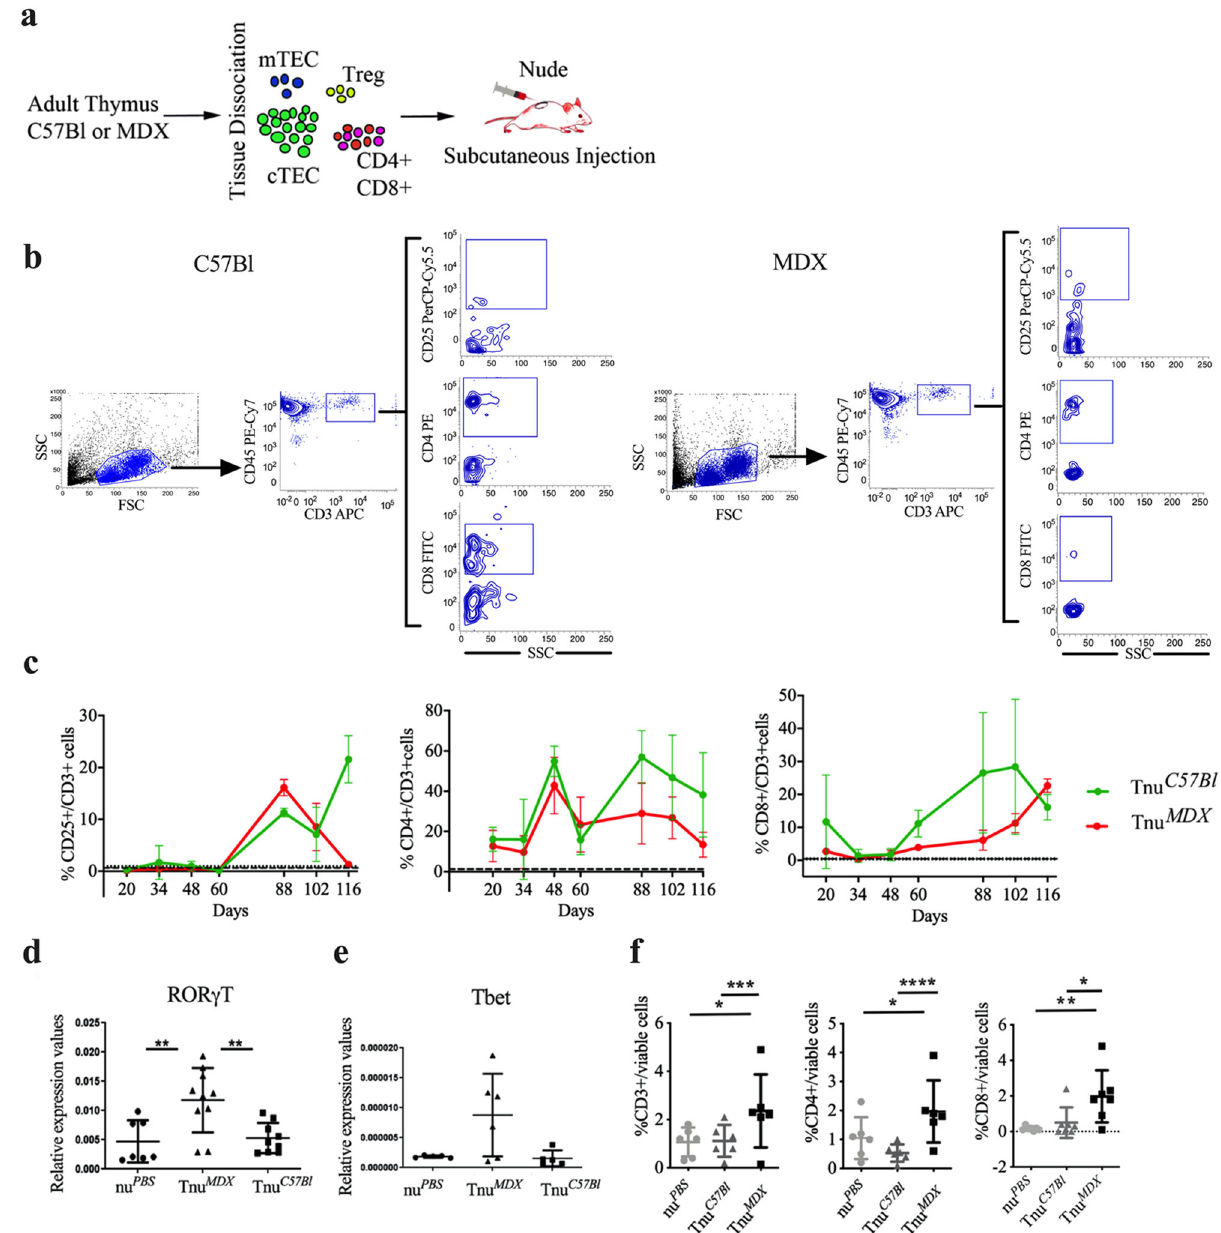
Fig. 5 Characterization of nude mice following adult thymus transplantation. Schematic overview of the experimental procedure ( a ). Gating strategy to identify CD25 + /CD3 + , CD4 + /CD3 + and CD8 + /CD3 + cell subpopulations in Tnu C57Bl and Tnu MDX mice. All subpopulations are detected within CD45 + CD3 + gate ( b ). FACS analysis of CD3-expressing blood-derived subpopulation isolated from Tnu C57Bl and Tnu MDX mice at different days following the thymus transplantation. Dashed lines referred to averaged values of nu PBS mice used as controls. The number of the CD3 + , CD4 + and CD8 + T cells were signi fi cantly higher in Tnu MDX muscles related to Tnu C57Bl and nu PBS mice ( c ). RT-qPCR analysis revealed signi fi cant over-expression of Th17 key gene, ROR γ t ( d ) and the upregulation of Th1 key gene T-bet ( e ) in muscles of Tnu MDX mice. f FACS analysis of muscles isolated from Tnu C57Bl , nu PBS mice and Tnu MDX mice for quanti fi cation of mature in fi ltrating T cells. The number of the CD3 + , CD4 + and CD8 + in fi ltrating T cells were signi fi cantly higher in Tnu MDX muscles related to Tnu C57Bl and nu PBS mice. The comparisons among the averages of the groups were evaluated using Linear regression analysis ( b ) and one-way ANOVA ( d – f ). c * p = 0.0085 (CD3 + CD25 + T cells: Tnu C57Bl vs Tnu MDX mice at day 116 pt); CD3 + CD25 + T cells in Tnu MDX mice: **** p < 0.0001, day 88 vs day 116 pt; *** p = 0.0077 day 88 vs day 102 pt; * p = 0.0383 day 102 vs day 116 pt; CD3 + CD4 + T cells in Tnu MDX mice: * p = 0.0482, day 88 vs day 116 pt; CD3 + CD8 + T cells in Tnu MDX : **** p < 0.0001, day 88 vs day 116pt; * p = 0.0392, day 88 vs day 102 pt; *** p = 0.0010, day 102 vs day 116 pt; CD3 + CD25 + T cells in Tnu MDX mice over time: * p = 0.026. d ** p = 0.0050 (Tnu MDX vs Tnu C57Bl ); ** p = 0.0097 (Tnu MDX vs nu PBS ). f CD3 + T cells: *** p = 0.0011 (Tnu MDX vs Tnu C57Bl ) and * p = 0.0203 (Tnu MDX vs nu PBS ); CD4 + T cells: *** p < 0.0001 (Tnu MDX vs Tnu C57Bl ) and * p = 0.0105 (Tnu MDX vs nu PBS ); CD8 + T cells: * p = 0.013 (Tnu MDX vs Tnu C57Bl ) and ** p = 0.0016 (Tnu MDX vs nu PBS ). Data are presented as mean ± SD of three independent experiments with n = 4 mice Tnu C57Bl and n = 5 mice Tnu MDX ( c ); n = 8 mice Tnu C57Bl , n = 9 mice Tnu MDX and n = 7 mice nu PBS ( d ); n = 5 mice Tnu C57Bl , n = 6 mice Tnu MDX and n = 5 mice nu PBS ( e ); n = 6 mice/group for % of CD3 + and CD4 + , n = 7 mice /group for % of CD8 + ( f ). Source data are provided as a Source Data fi le.